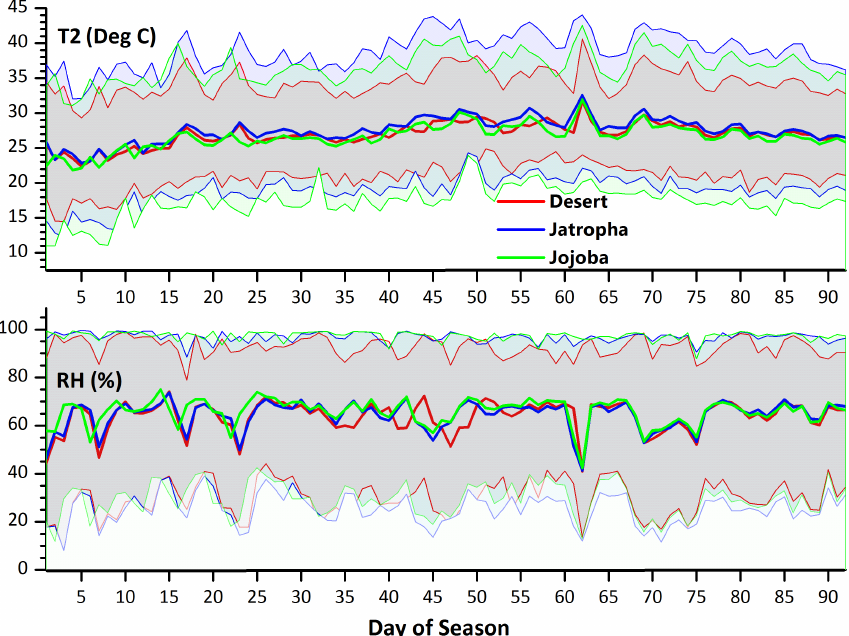
Fig. 2. Observed daily mean, maxima and minima of 2m air temperatures and relative humidities for the Desert, Jatropha and Jojoba stations – summer 2012 (JJA). The thick curves at the centre of the shaded areas are the daily mean values. The upper and lower thin lines bounding the shaded areas are the daily maxima and